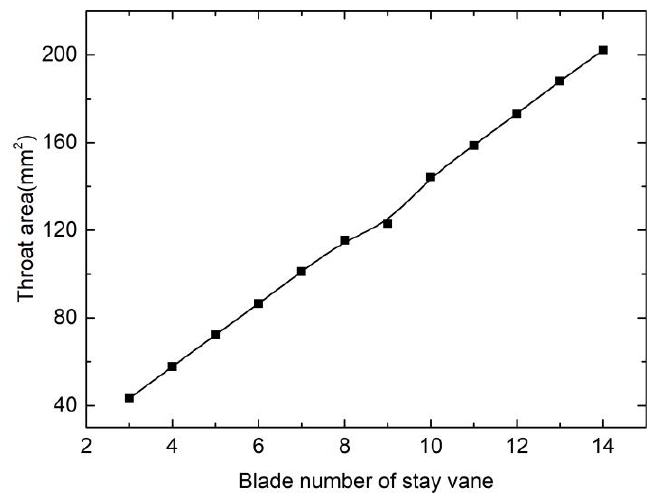
Figure 10. Throat area under a different number of stay vane blades.